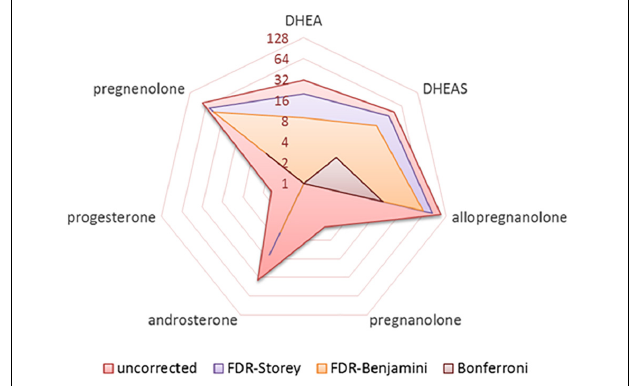
FIGURE 1 | Radar plot showing the number of significant results (log base-2) obtained from bivariate correlations of seven neurosteroids with 148 cortical regions (1036 total tests) for various approaches to handling multiple comparisons including uncorrected, FDR correction of Benjamini and Hochberg, pFDR correction of Storey, and Bonferroni correction.